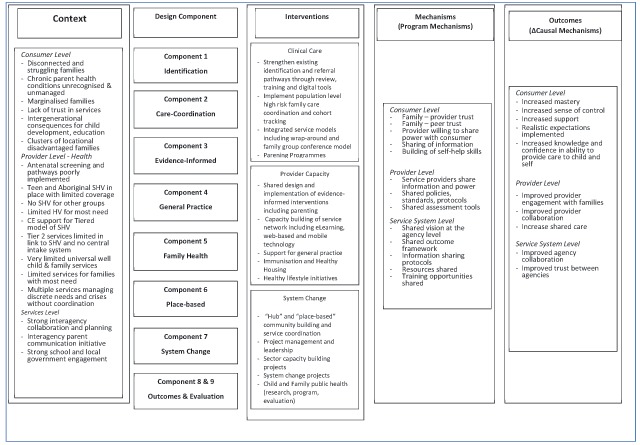
ToC Logic Model.